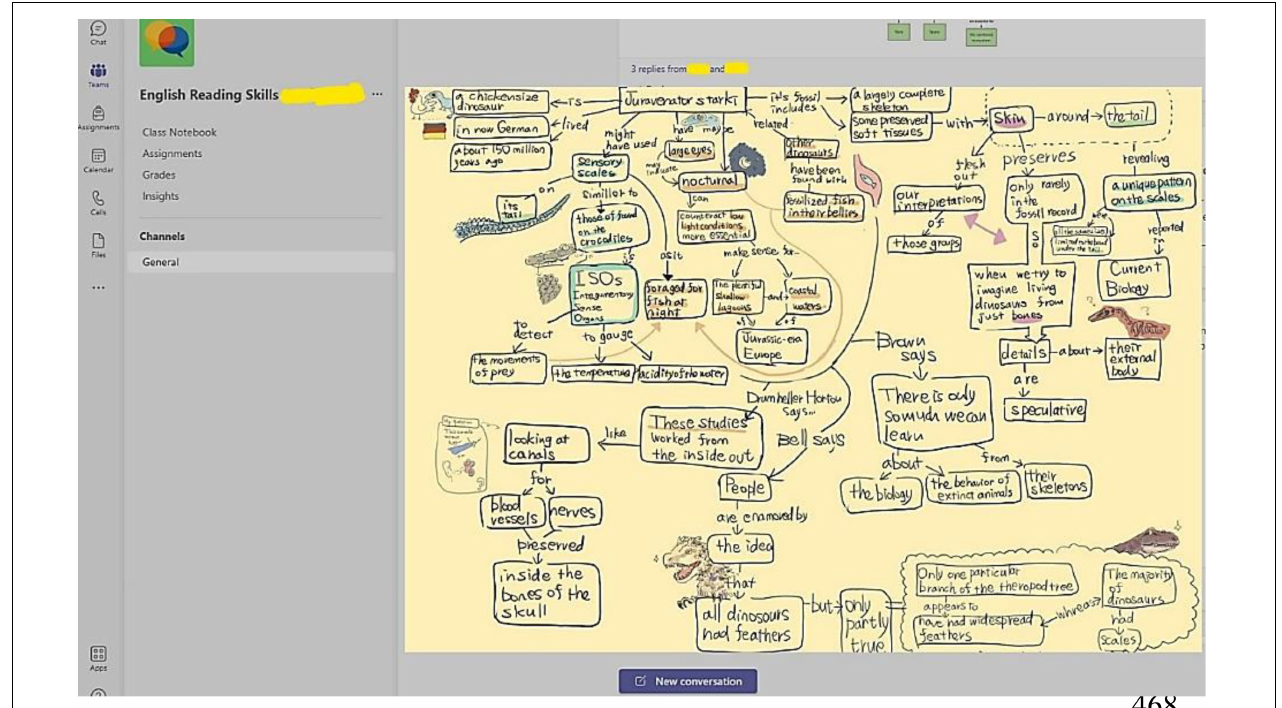
FIGURE 3 | Students’ use of various tools, such as concept maps and KWL. Microsoft and Microsoft Teams are trademarks of the Microsoft group of companies.